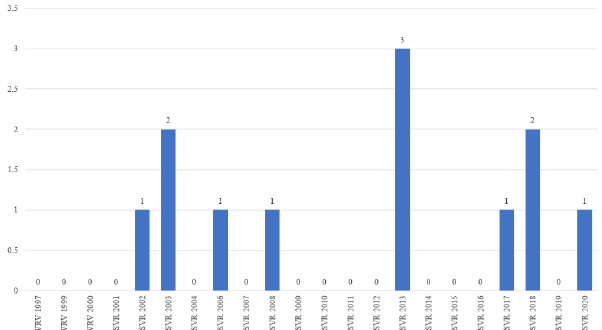
Figure 16. Overall distribution of papers from the “Haptics/audio/other non- visual interfaces”